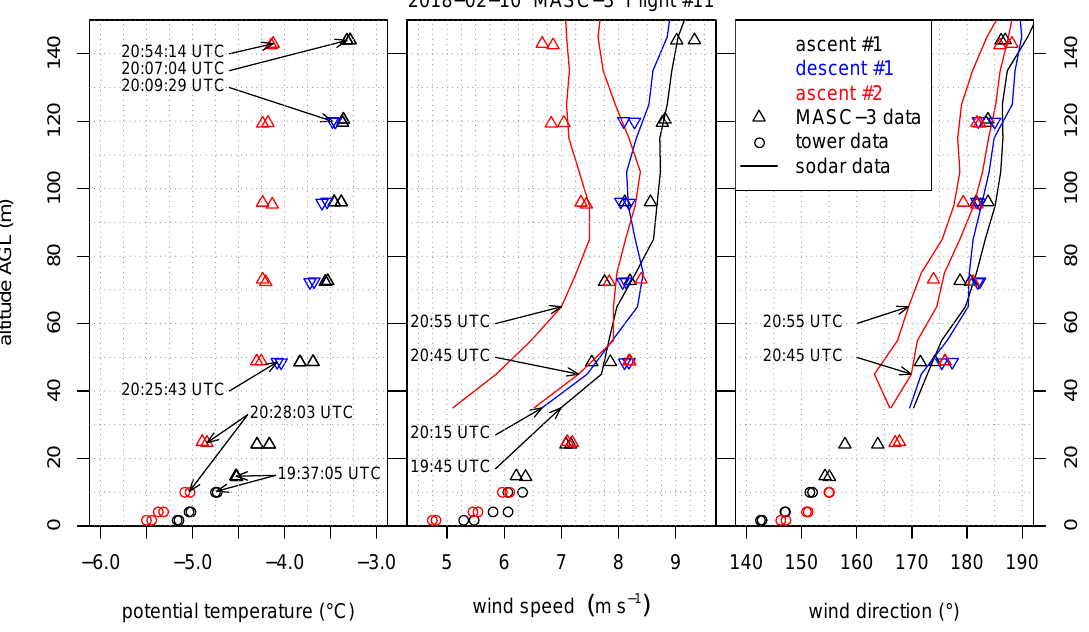
Figure 14. MASC-3 Flight #11 alongside the corresponding tower data and Sodar data as height profile for the potential temperature θ ( left ), the horizontal wind speed v h ( middle ) and the wind direction φ ( right ). The time series of the tower data points have a duration of ∆ t tower = 170 s, corresponding to the fetch of the MASC-3 flight legs at the lowest levels with an average duration of ∆ t UAS = 55 s. The timestamps of the first measurement points of each profile and the timestamps of the Sodar profiles are